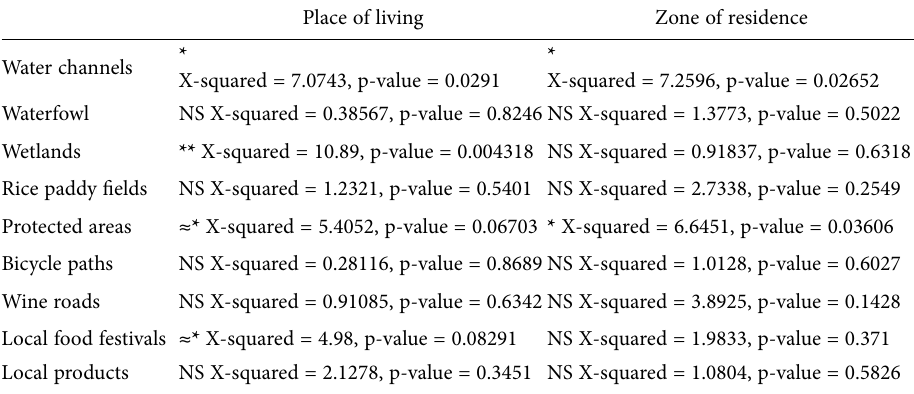
Table 3. relation between place of living, zone of residence and the frequency of differentiated per- ceptions of benefits from the landscape elements for agriculture, tourism and residents in the sample. Chi-square test and p-values (* = < 0.05; **= < 0.01; ns= not significant) of differences (cfr. Appendix B for Pearson